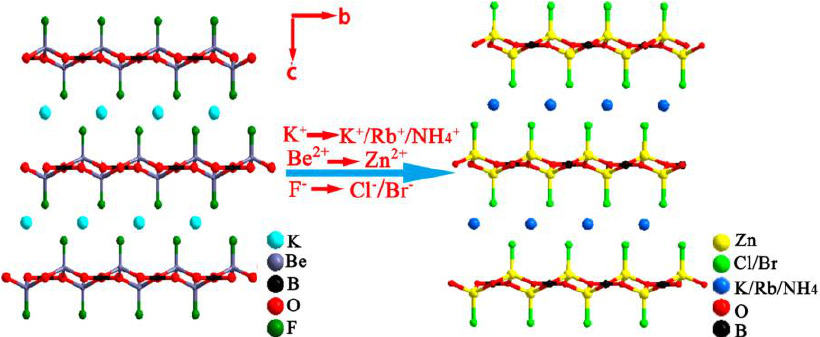
Figure 2. Structural evolution from KBBF to AZn 2 BO 3 X 2 . Reprinted with permission from Ref. [58]. Copyright (2016) American Chemical Society.